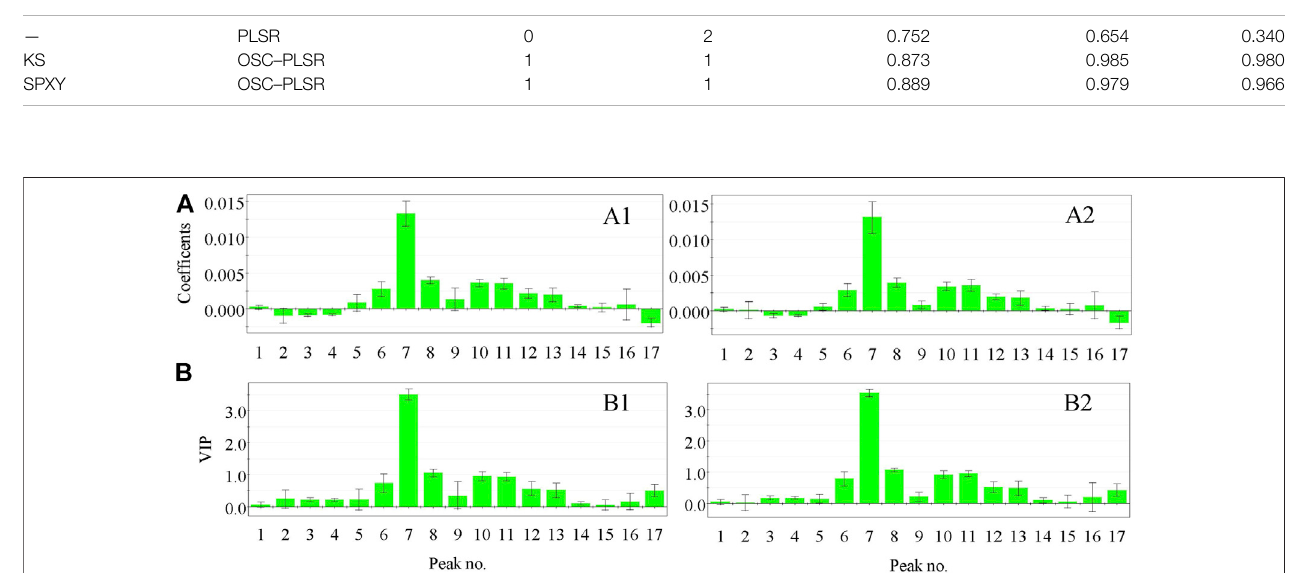
FIGURE 3 | Coef fi cient plot (A) and VIP plot (B) of the OSC – PLS model grouped using the KS and SPXY method. (A1) Coef fi cient plot of the OSC – PLS model groupedusingtheKSmethod, (B1) VIPplotoftheOSC – PLSmodelgroupedusingtheKSmethod, (A2) Coef fi cientplotoftheOSC – PLSmodelgroupedusingtheSPXY method, and (B2) VIP plot of the OSC – PLS model grouped using the SPXY method.